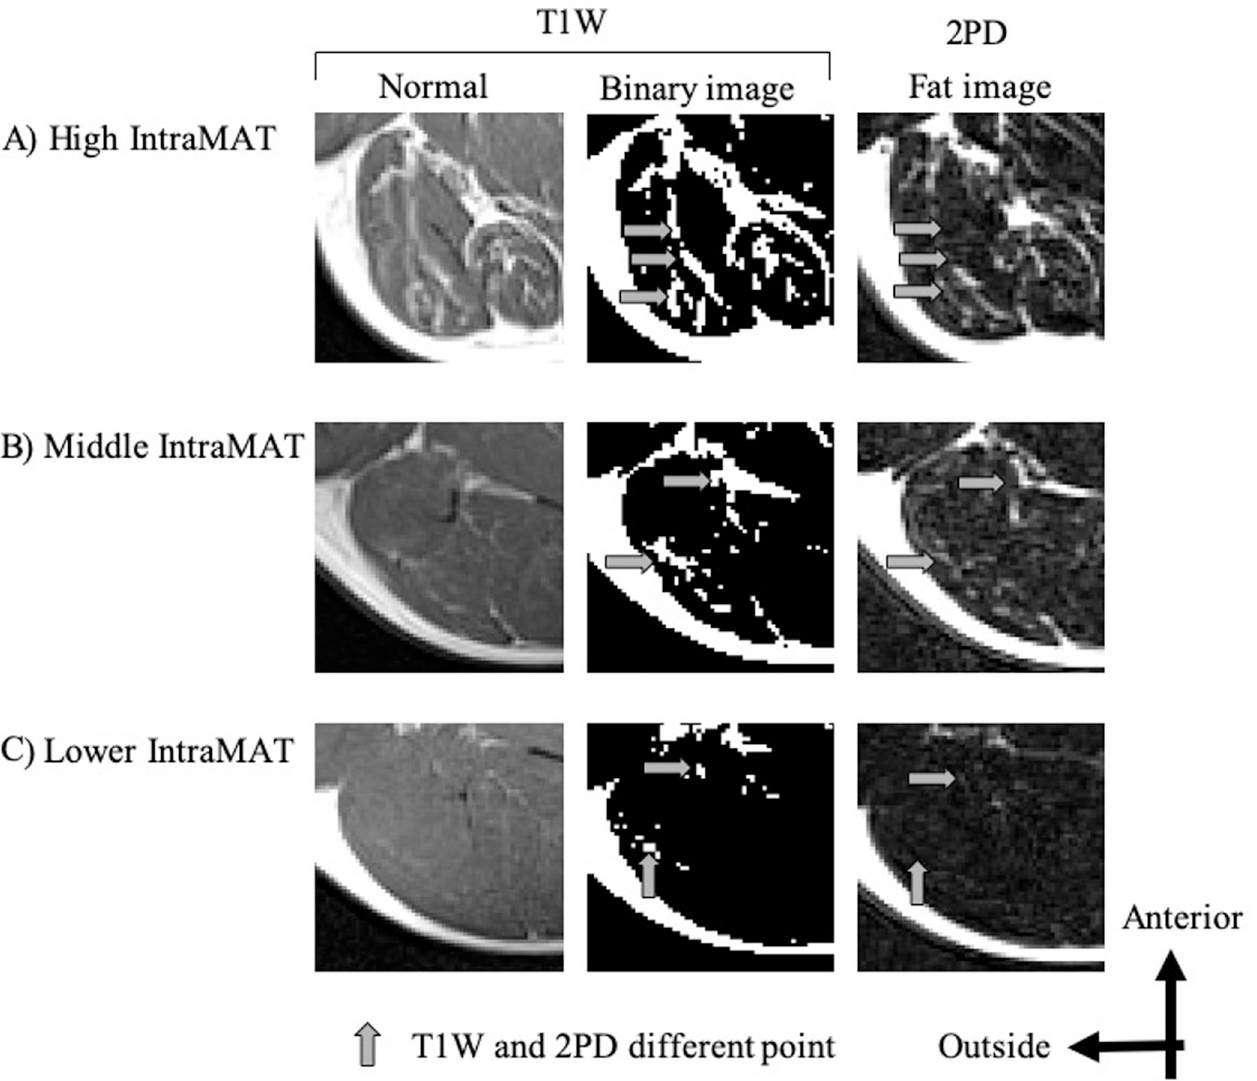
Fig 4. Representative T1-Weighted (T1W) images and fat images by 2-Point Dixon (2PD) of the Biceps Femoris-Long head (BF-L). Normal: T1W image after optimized image correction parameters (N3). Binary image: T1W image binarized with threshold value. Upper: subject with high IntraMAT content = 40.1% (T1W), 15.0% (2PD); Middle: subject with moderate IntraMAT content = 20.4% (T1W), 17.7% (2PD); Lower: subject with low IntraMAT content = 6.5% (T1W), 7.1% (2PD).